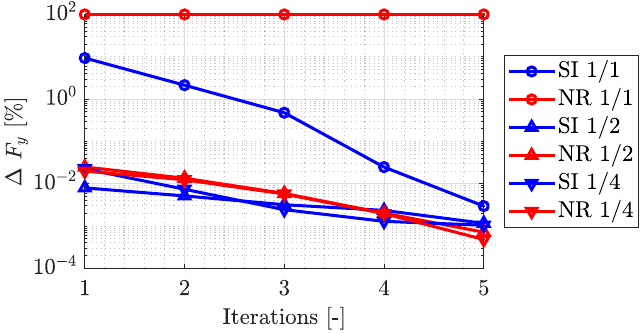
Figure 7. Convergence of the attraction force regarding SI and NR solver iterations, for Benchmark I for different h-refinements, with p = 4 in